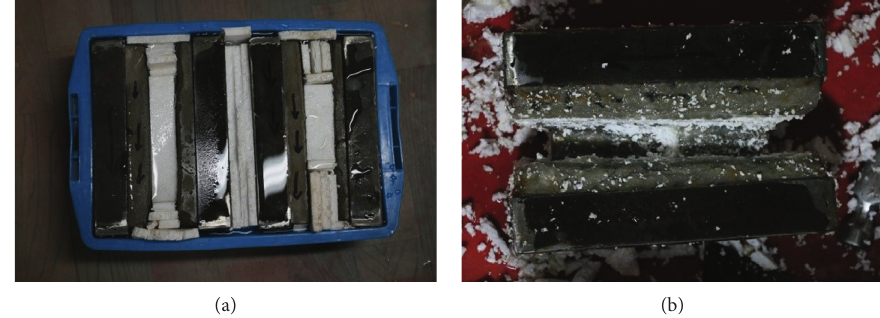
Figure 4: Photographs of the specimen before and after freezing.